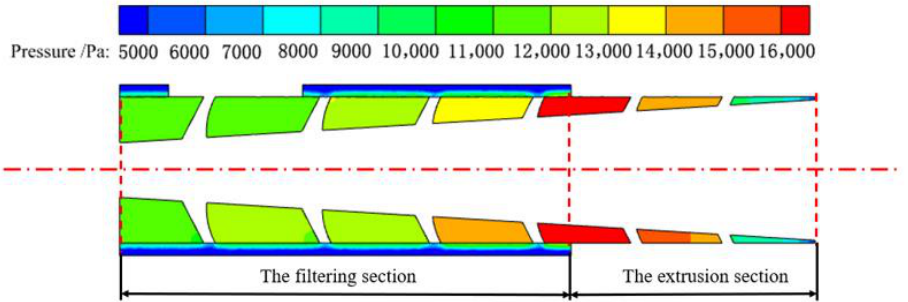
Figure 6. Pressure distribution in spiral cavity.